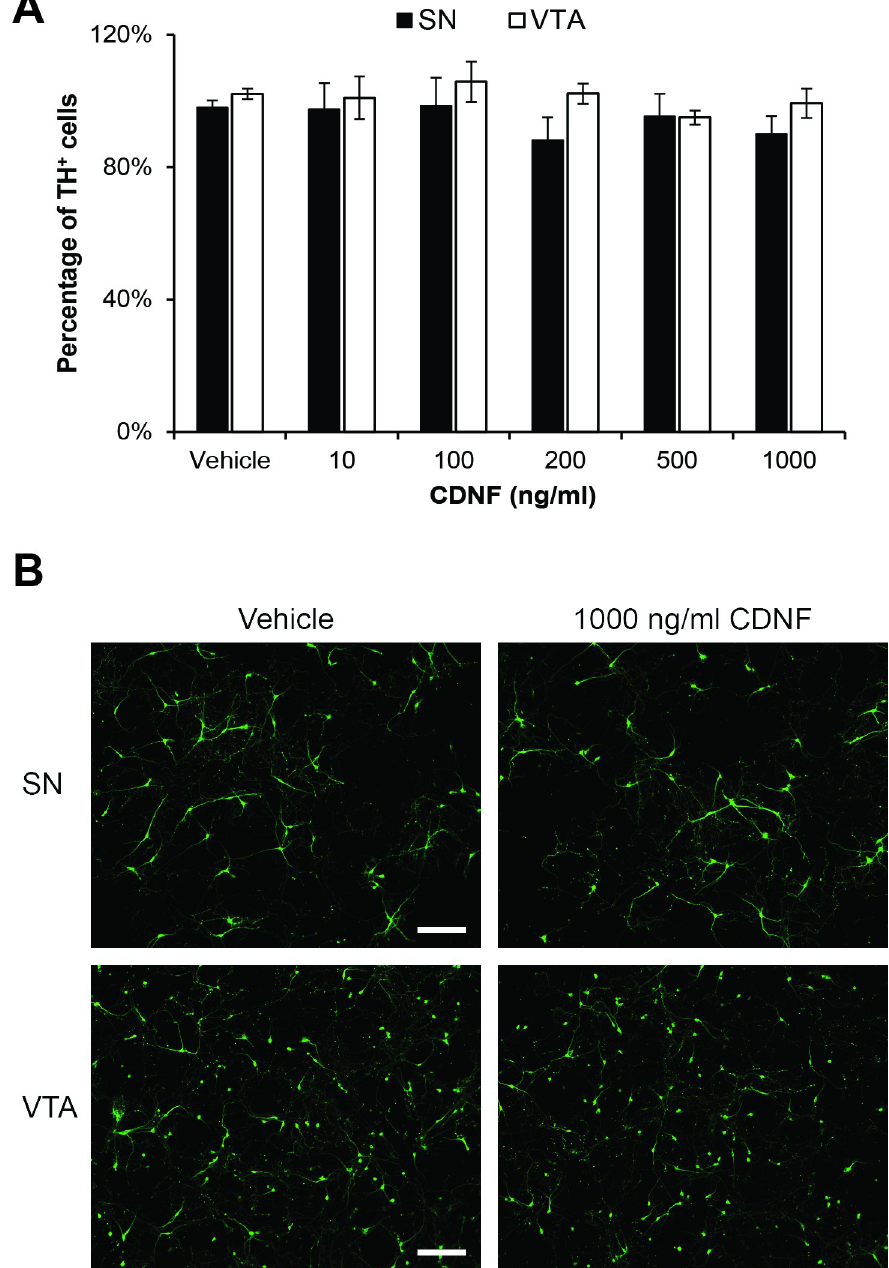
Fig 1. Effect of CDNF on basal survival of DA cells as indicated by TH + immunoreativity cells after six days in culture. A) Neither cells isolated from the SN (closed bars) nor from the VTA (open bars) were affected by CDNF (0– 1000 ng/ml) added the day of culture preparation. Graph represents average of cells compared to untreated control; n = 4 experiments per condition. B) Representative images of cells isolated from the SN (top) or VTA (bottom) cultured for 6 days with or without 1000 ng/ml of CDNF immunostained for TH (green). Scale bars indicate 200 microns.